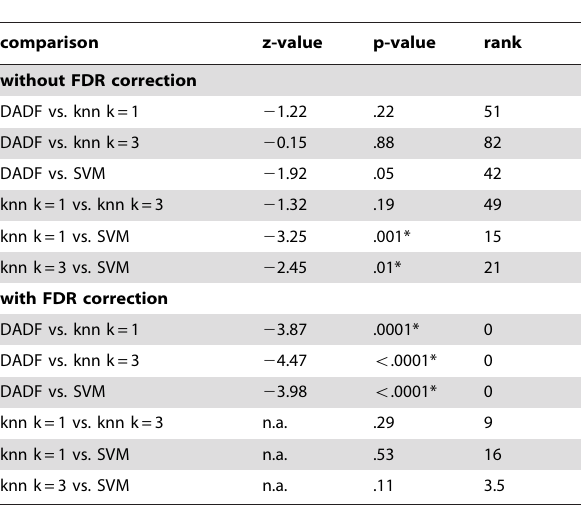
Results of Wilcoxon-tests comparing the number of healthy participants with above-chance accuracies. Upper set based on above-chance numbers without FDR-correction, lower set with